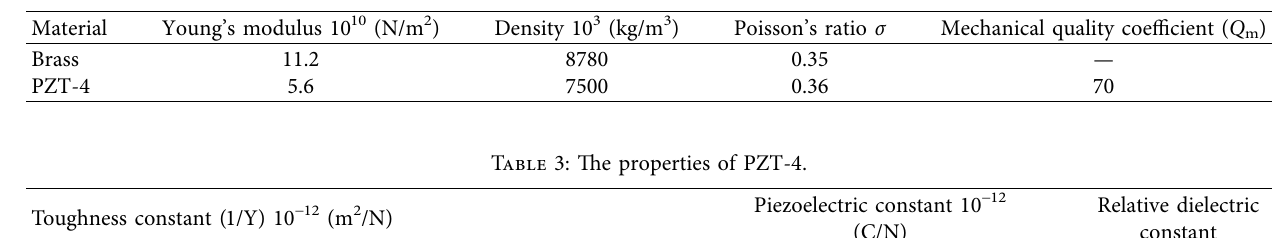
Figure 9: Pneumatic frequency in the channel. (a) The original frequency with OWC. (b) The shedding pneumatic frequencies. Table 2: Materials of the piezoelectric vibrator.